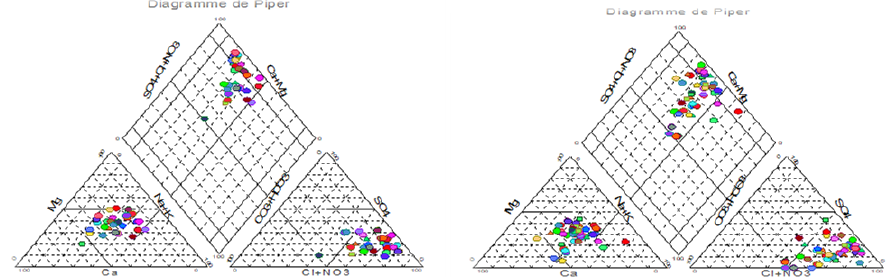
Figure 3. Piper diagram for waters downstream ( left ) and upstream ( right ).